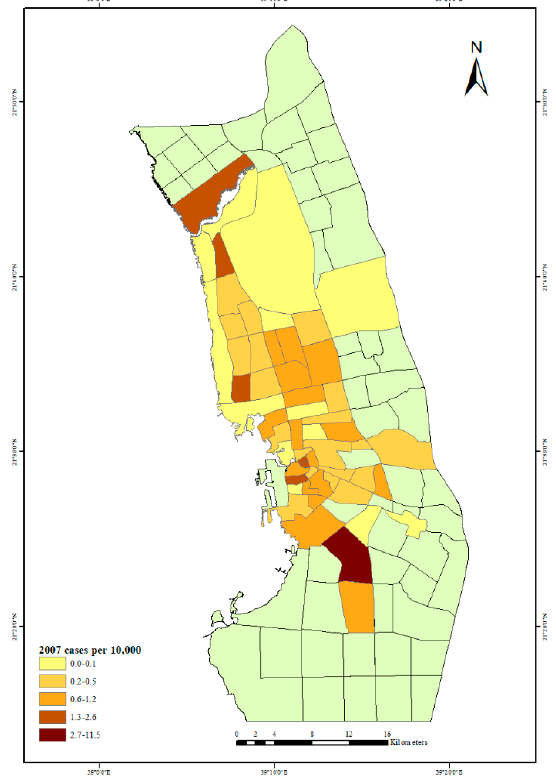
Figure 4. Dengue fever cases per 10,000 people in Jeddah City, 2007.